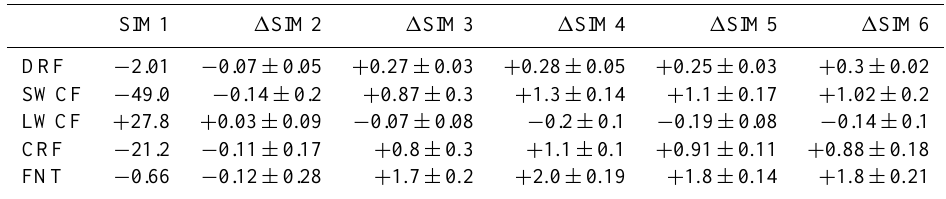
Table 3. Global annual mean differences of aerosol direct (DRF), semi-direct and indirect (CRF), and net effect at the TOA (FNT) (positive values mean incoming, units: Wm − 2 ) in different simulations ∗ .